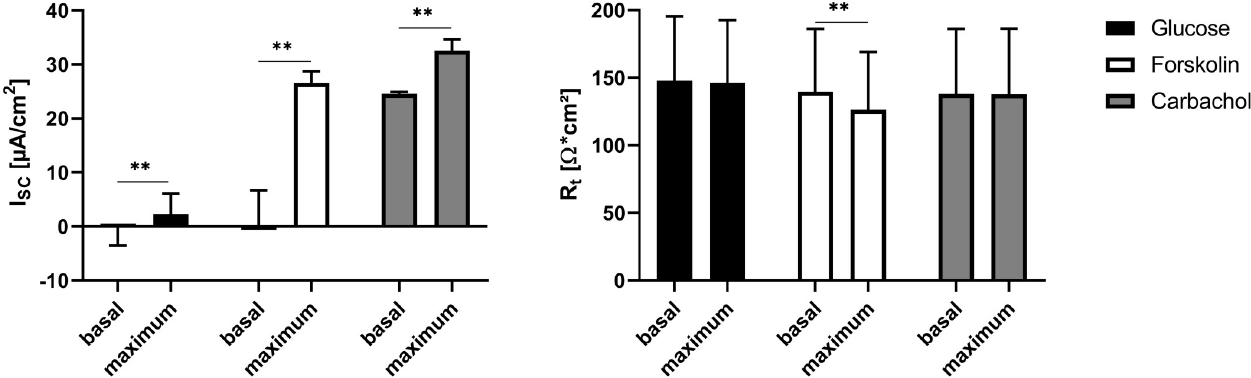
Fig 8. Basal and maximal I sc and R t values of organoid-based 2D monolayers cultivated for 18 days determined before and after subsequent addition of glucose, carbachol and forskolin. Values shown are the mean ± SD of four independent experiments. �� p < 0.01.